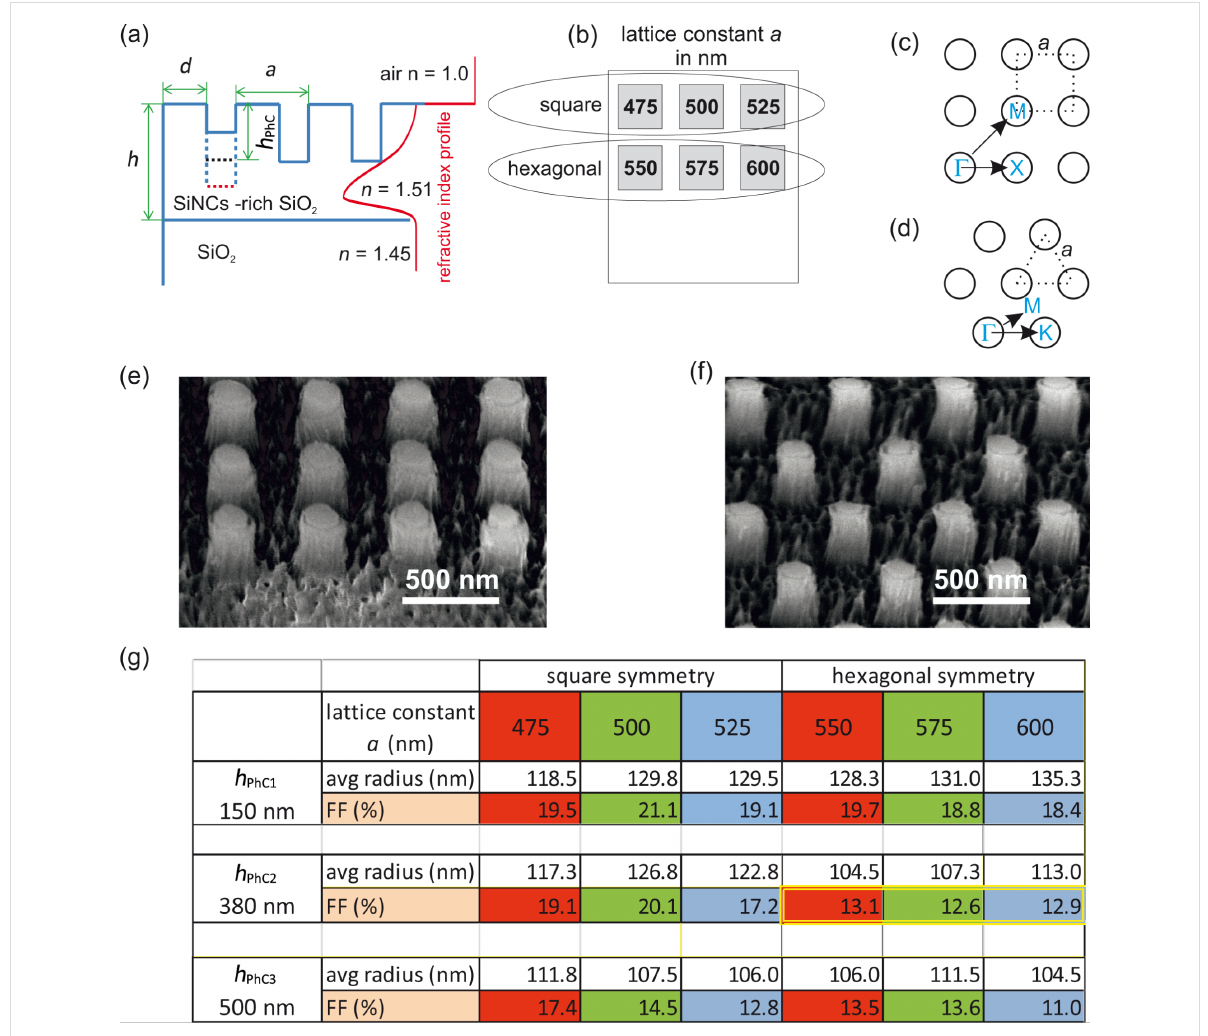
Figure 1: Samples under study. (a) Schematic cross section of the PhC sample. Red line shows the spatial distribution of the refractive index in the sample (not in scale). (b) Layout of the PhC samples fabricated on the SiNCs/SiO 2 layer. Three samples with different height of the columns were prepared by increasing the etching time. Each of the three samples contains six PhC structures (the size of each is 1.3 mm × 1.3 mm) with lattice con- stants specified in the image in nanometers. (c, d) Schematic images of the square and hexagonal lattice symmetries with lattice constant a , respec- tively. The relevant directions of high symmetry along which the angle-resolved PL spectra were measured are also depicted. (e, f) SEM images of the square ( a = 475 nm) and hexagonal ( a = 550 nm) PhCs with the height h PhC2 , respectively. (g) Table containing parameters of the samples: FF - filling